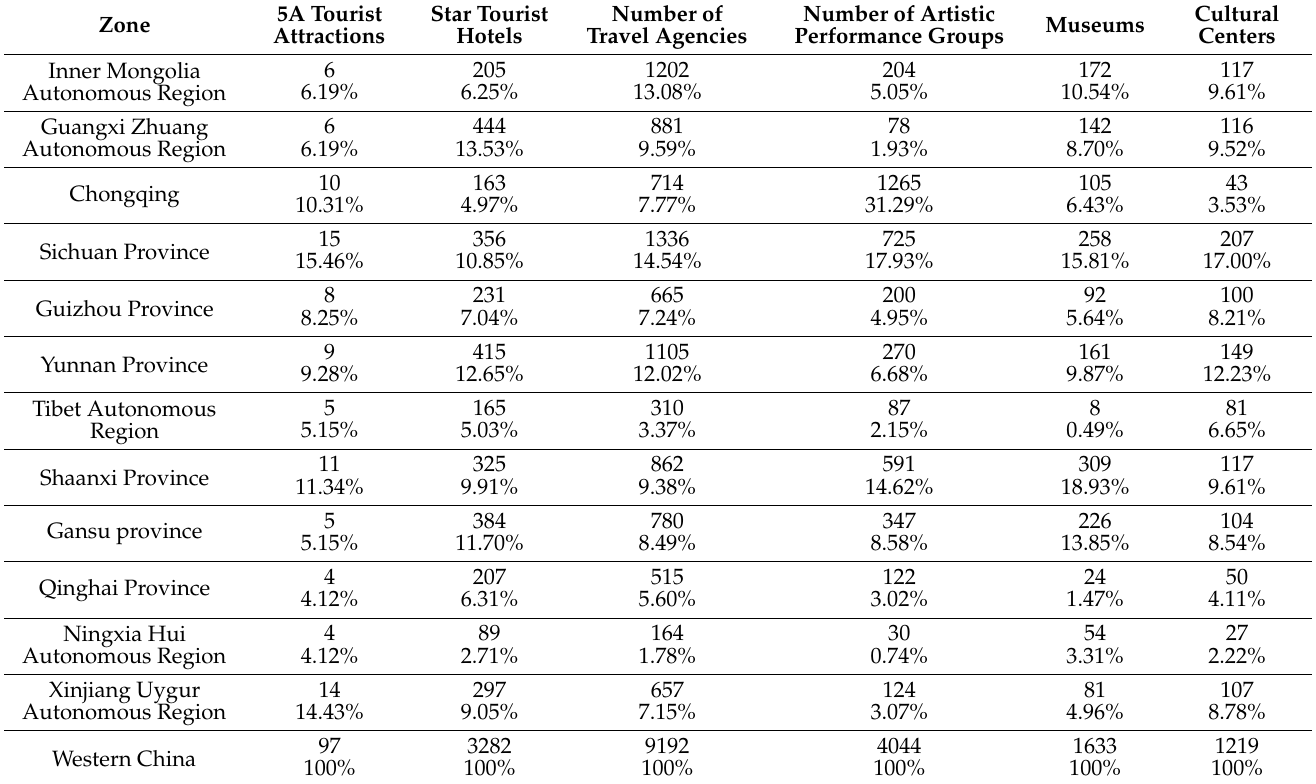
Figure 2. Location of the study area. Table 2. Major statistical changes in cultural tourism in